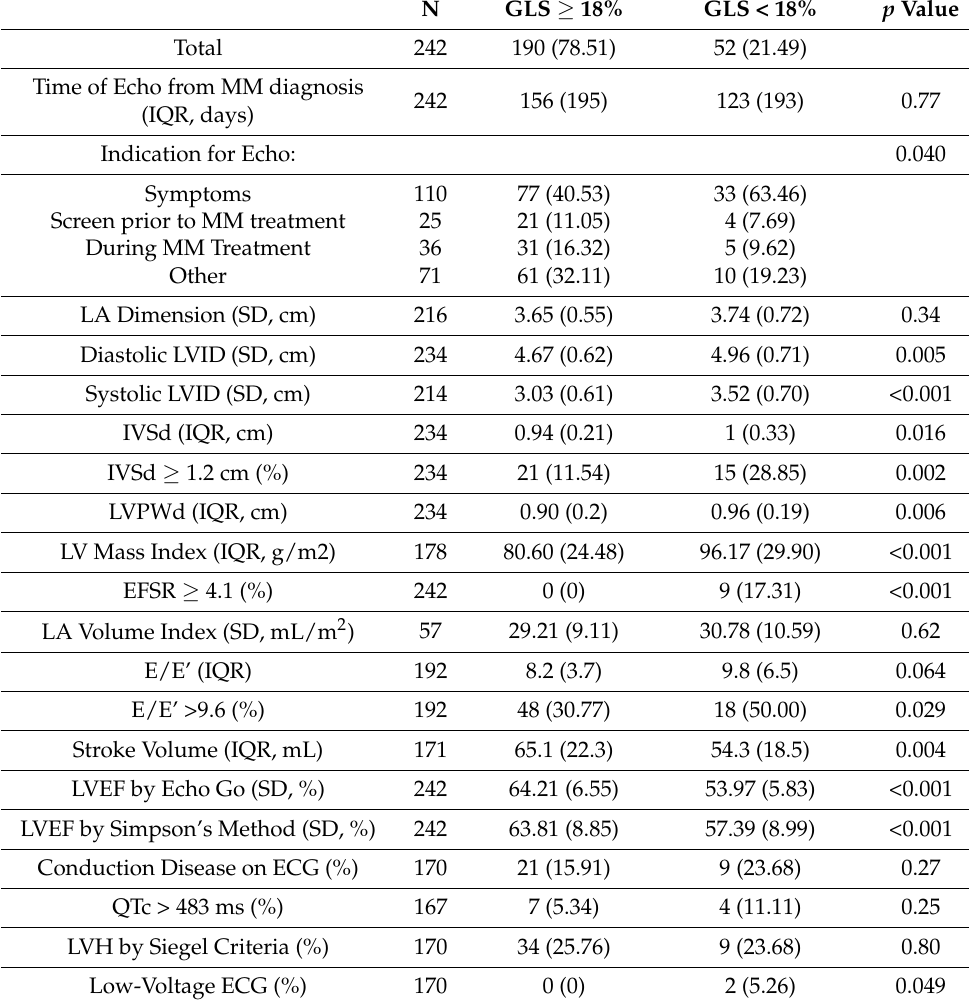
Table 2. Echo and ECG